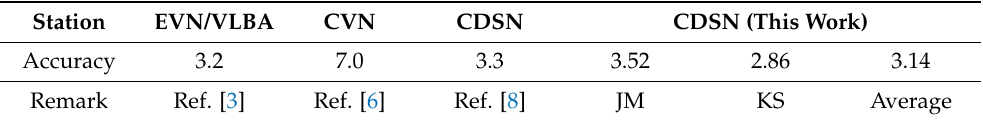
Table 1. Frequency error of MEX (mHz, 1 s integration).